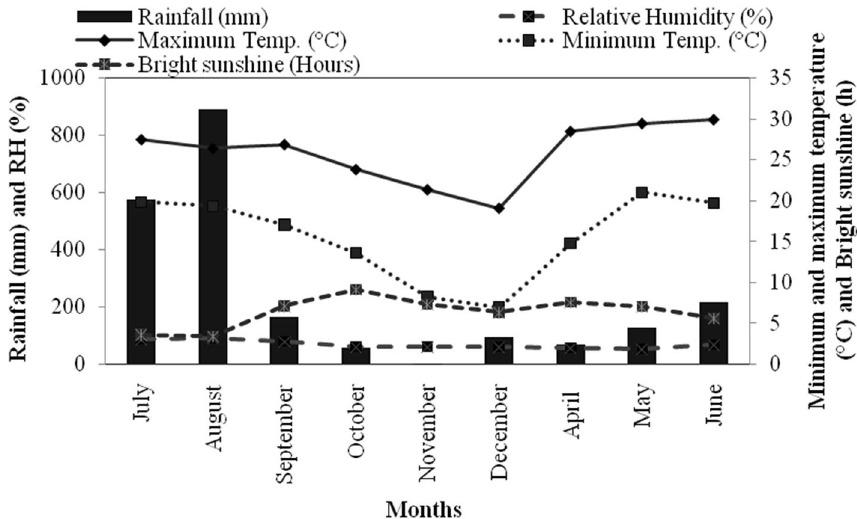
Figure 5. Mean monthly (seasonal) meteorological data during crop growth season (2018–2019) of rosemary at Palampur, Himachal Pradesh,